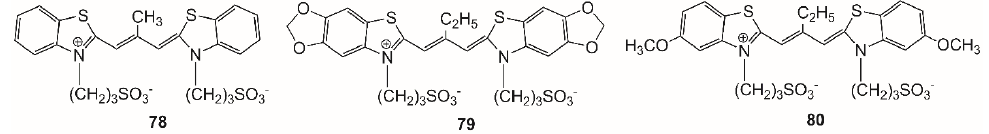
Figure 17. Structures of anionic meso ‐ substituted trimethine cyanines 78 – 80 .